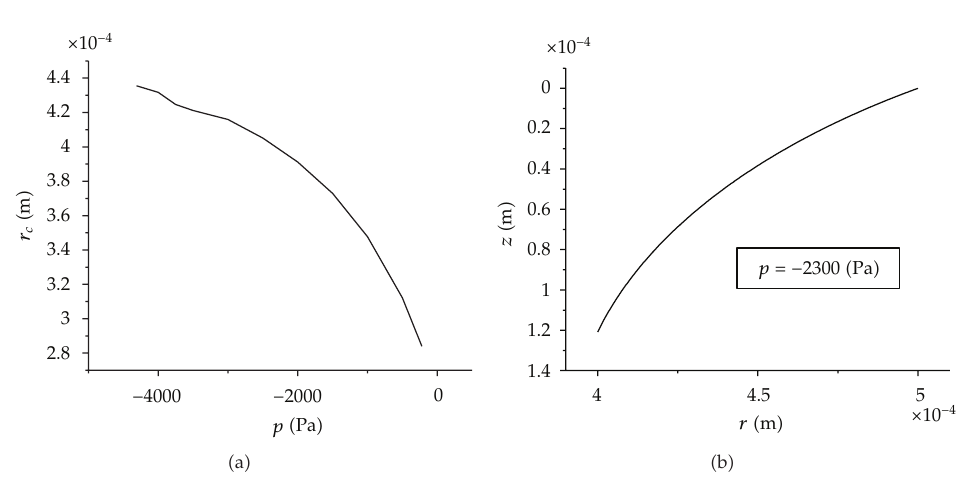
(cid:8) 0 . 523rad. (cid:6) b (cid:7) The convex meridian curve for p (cid:8) − 2300Pa, c